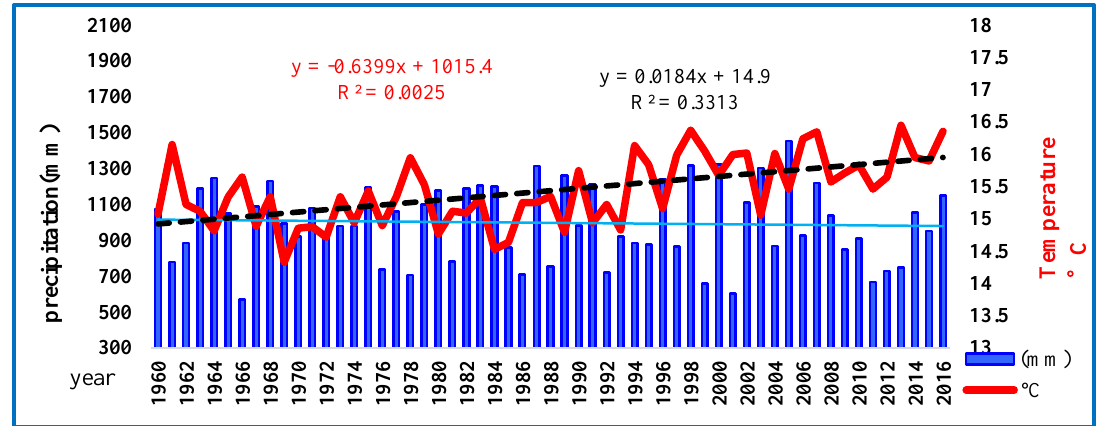
Figure 5. Mean annual precipitation and temperature of the Huai River Basin (1960 – 2016).